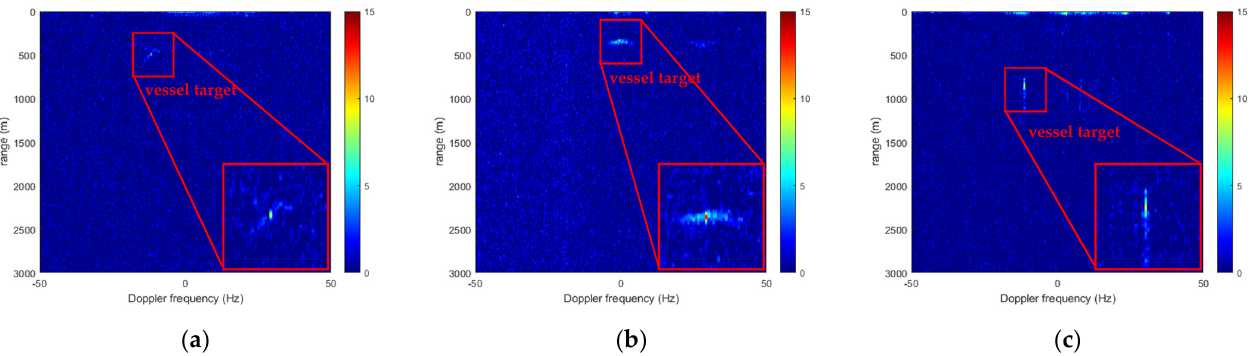
Figure 14. Final integrated RD map referring to the other BeiDou satellites: ( a ) C27, ( b ) C38, and ( c ) C40.